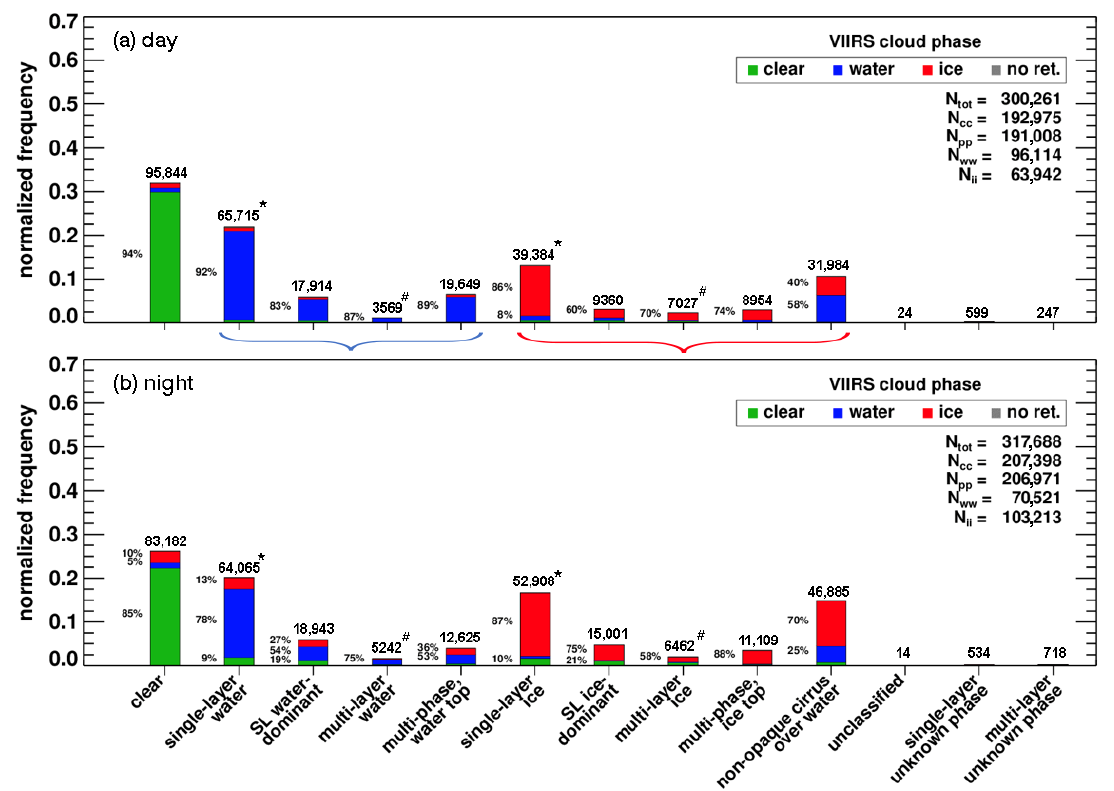
Figure 5. CV1S 0/100 ( a ) day and ( b ) night scene type fraction for various classifications as deter- mined from CALIOP HA ≤ 5 km data for collocations with ±2.5 min during JAJO 2015–2016. * denotes single-layer, single phase clouds. Brackets indicate all CALIOP classifications treated as liquid-phase (blue) and ice-phase (red) clouds in height and COD discussion.